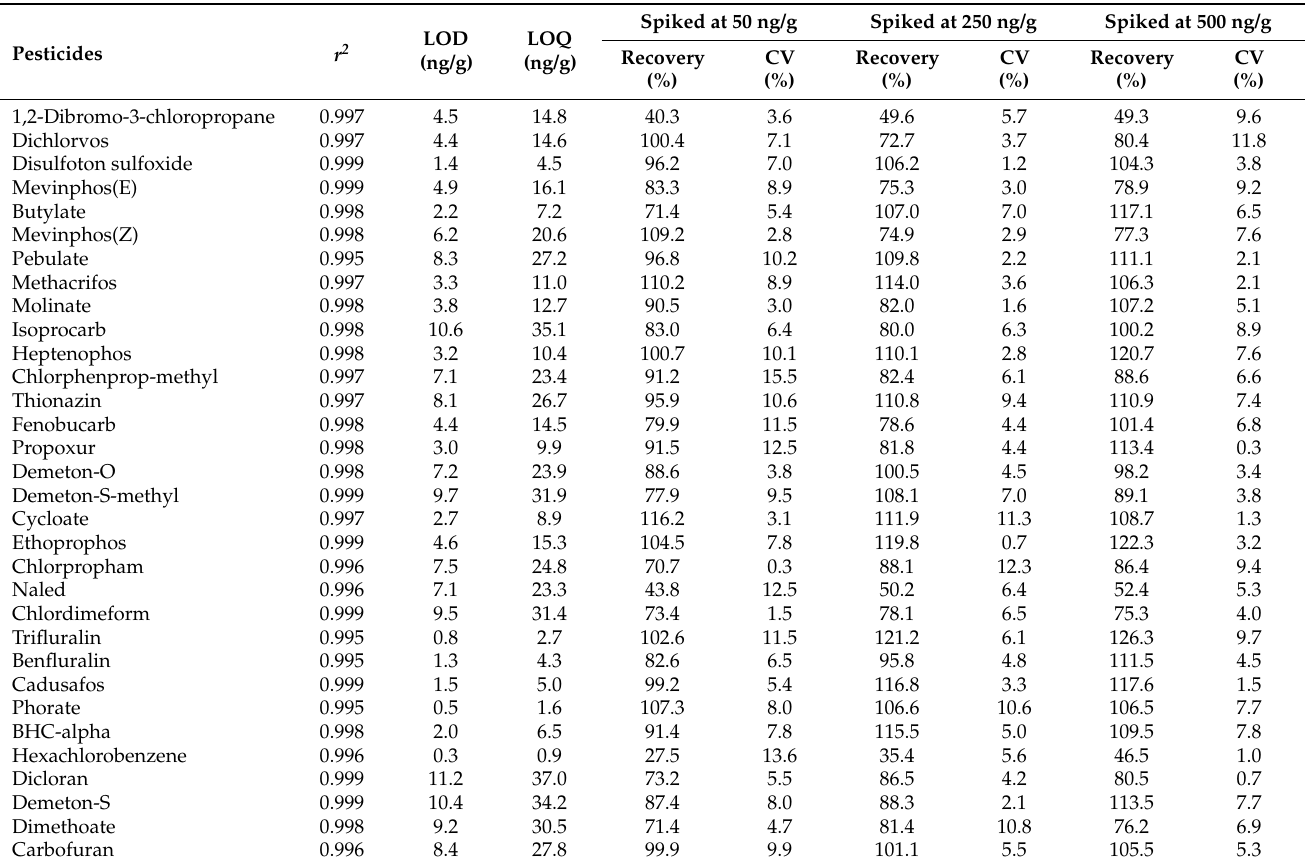
Table A1. The r 2 , LOD, LOQ, recovery, and CV values of the 209